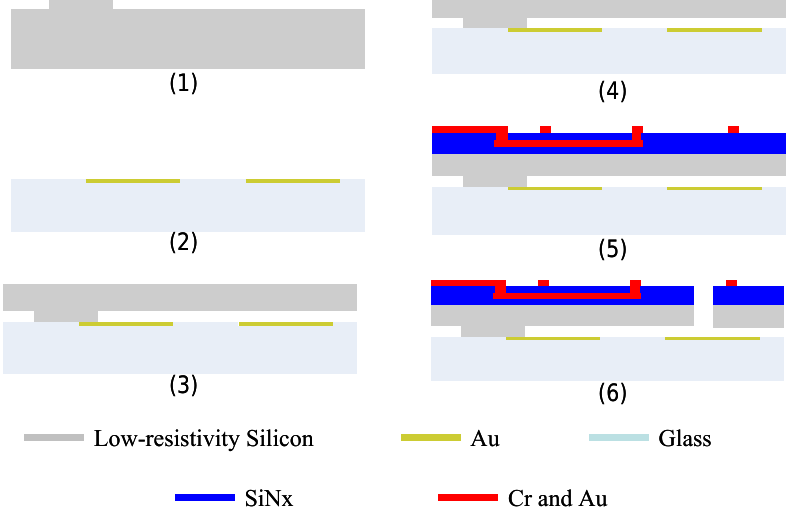
Figure 3. Fabrication process of the MEMS torsional resonant